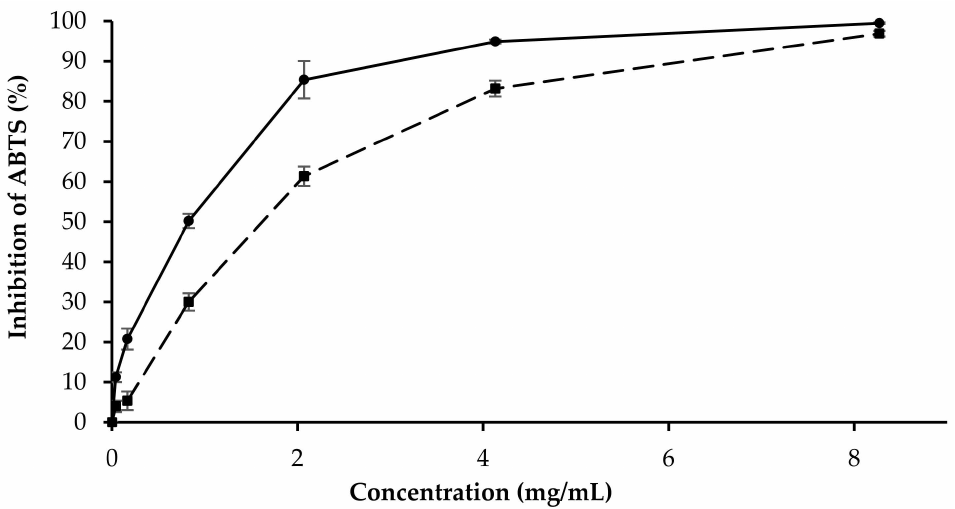
Figure 9. Scavenging effect of the two different essential oils of L. augustifolia , LA 2019 ( • ) and LA 2020 ( ▪ ) on ABTS assays at different concentrations ranging from 0.041 mg/mL to 8.5 mg/mL. Data are expressed as mean values ± SE ( n = 3).